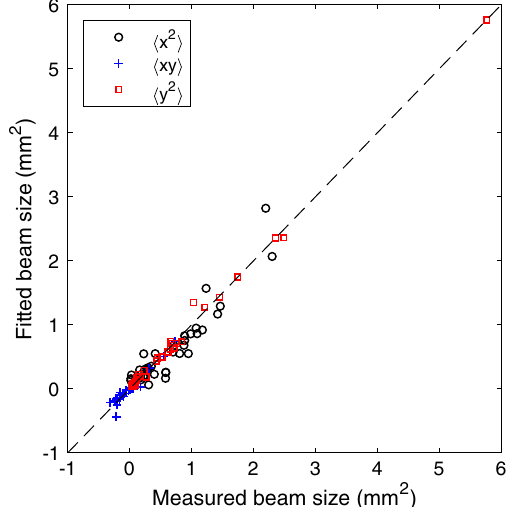
FIG. 5. Beam size at SCR-03 reconstructed by quadrupole scan analysis compared with the beam size observed directly on the screen. Each point corresponds to a different set of quadrupole strengths. Circles indicate the horizontal beam size h x 2 i ; boxes indicate the vertical beam size h y 2 i ; crosses indicate the hori- zontal-vertical correlation h xy i . The distances of the points from the dashed line (which passes through the origin with unit gradient) indicates the residuals to the fit, which are dominated by systematic errors. The observed images are highly reproduc- ible over a number of successive machine pulses, and the random variation in the measured beam sizes is correspondingly very small on the scale of the plot.